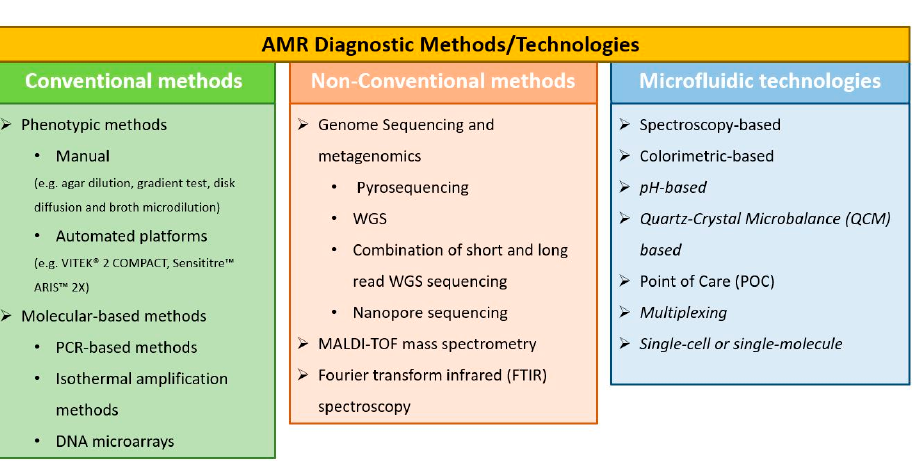
Figure 1. Summarizing chart of the methods and technologies analyzed in the present